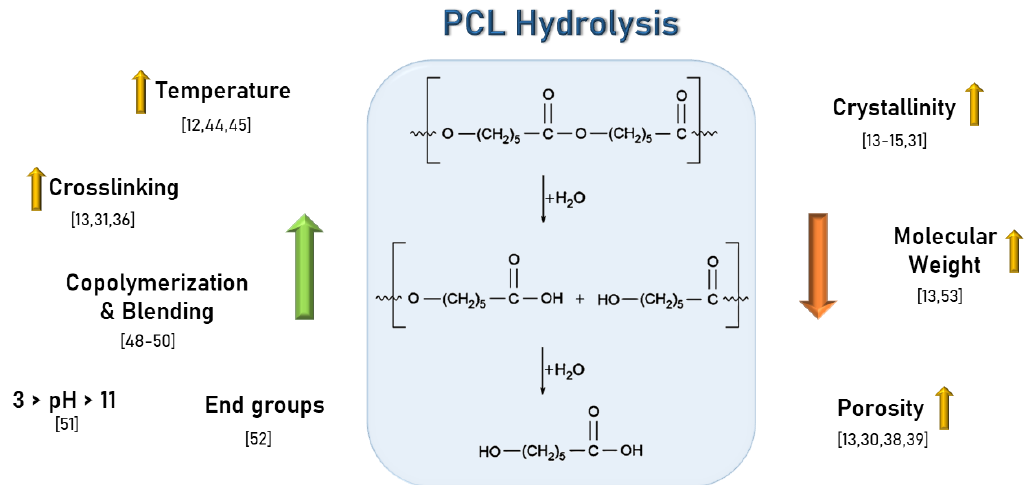
Figure 5. Variables reported for tuning the degradation rate of PCL.